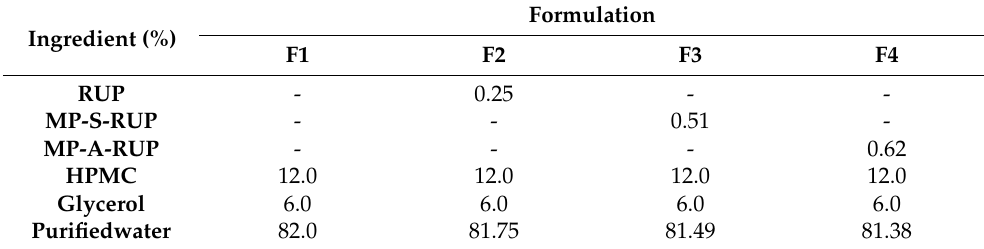
Table 1. Composition of casting solutions poured on the surface of the